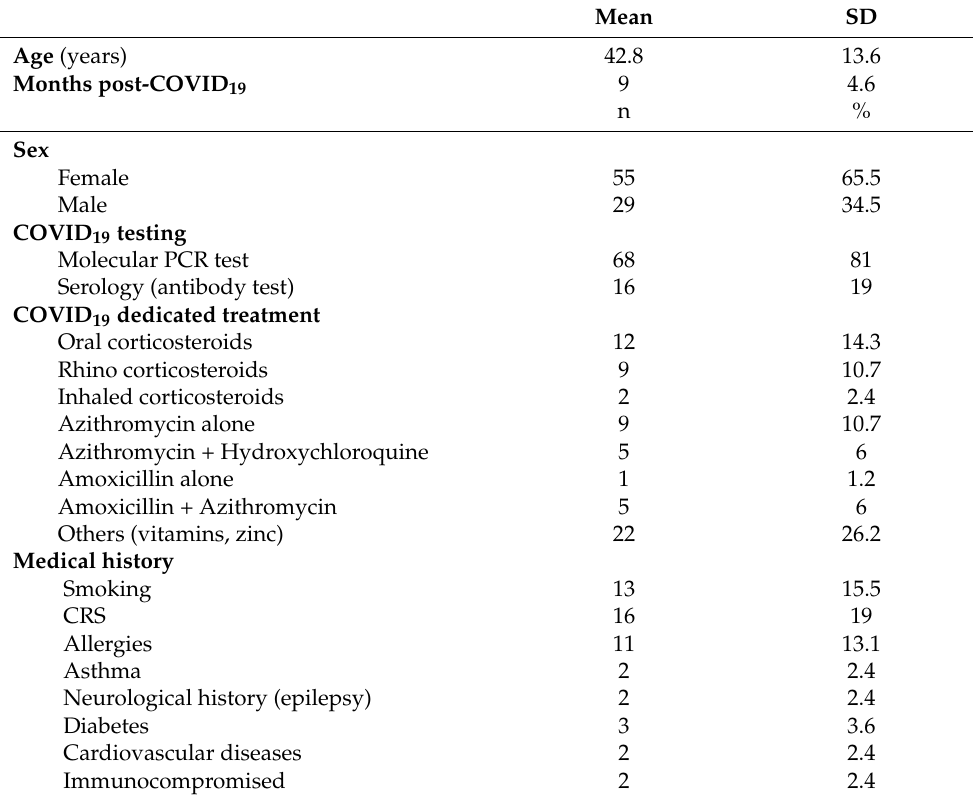
Table 1. Demographic and clinical characteristics. SD means Standard Deviation. CT = computed tomography; PCR = polymerase chain reaction; CRS = chronic